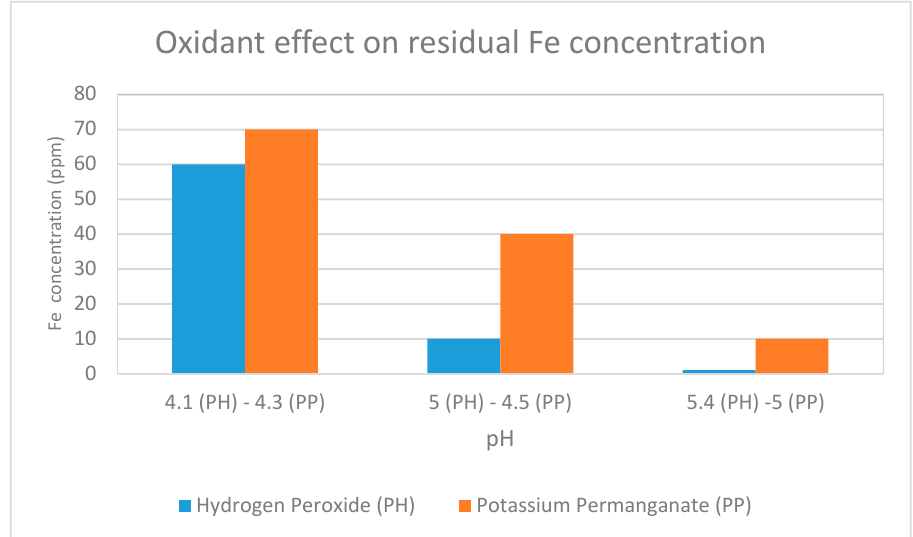
Figure 17. Oxidant effect on residual Fe concentration .